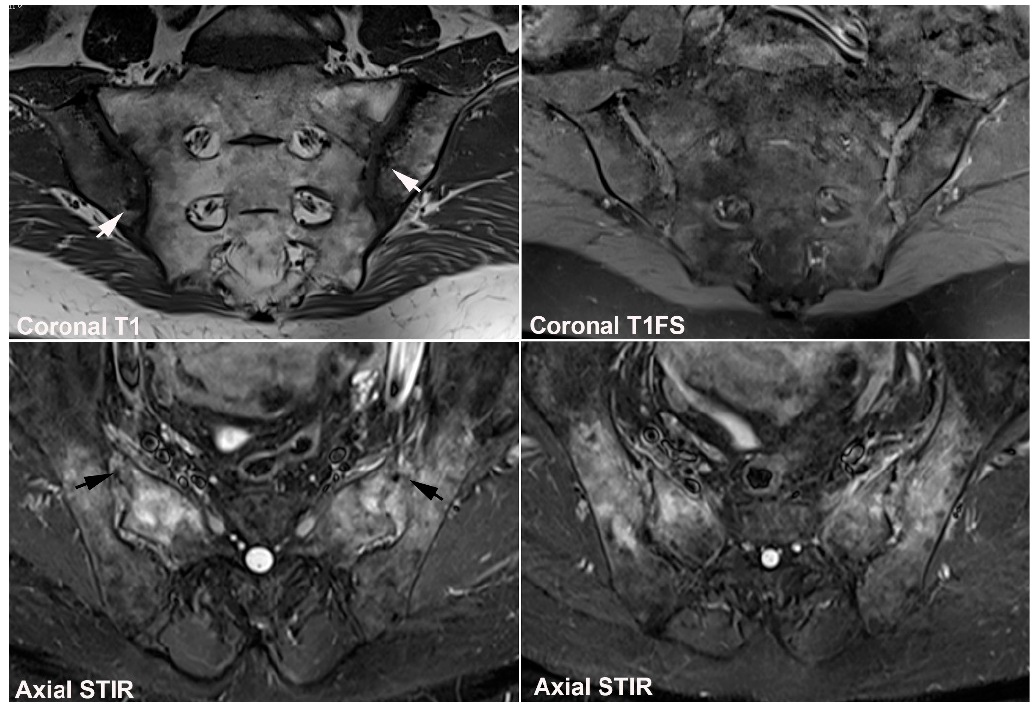
Figure 26. Gout changes in a 71-year-old woman with low back pain for approx. 12 months. MRI, semi-coronal T1 and T1FS, and two semi-axial STIR images in the middle of the joints showing relatively well-defined erosions filled with a material of intermediate-to-low signal intensity on T1 with dispersed surrounding sclerosis and small fat depositions (white arrows). The STIR images show inhomogeneous edema in the joint space with intraarticular small signal void areas (black arrows) and there is surrounding pronounced BME involving both the sacrum and the ileum. Biopsy confirmed the presence of crystals in the erosive